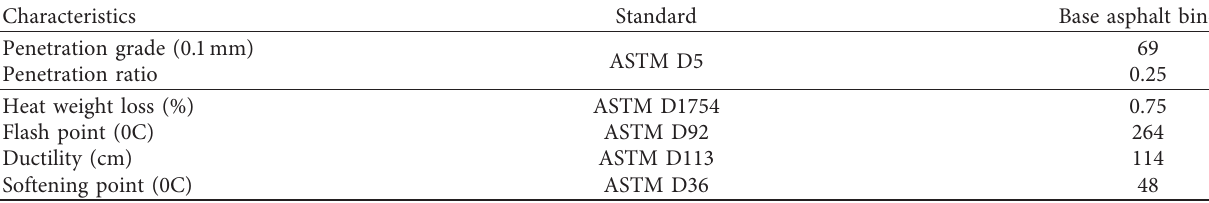
Table 2: The characteristics of base asphalt binder.